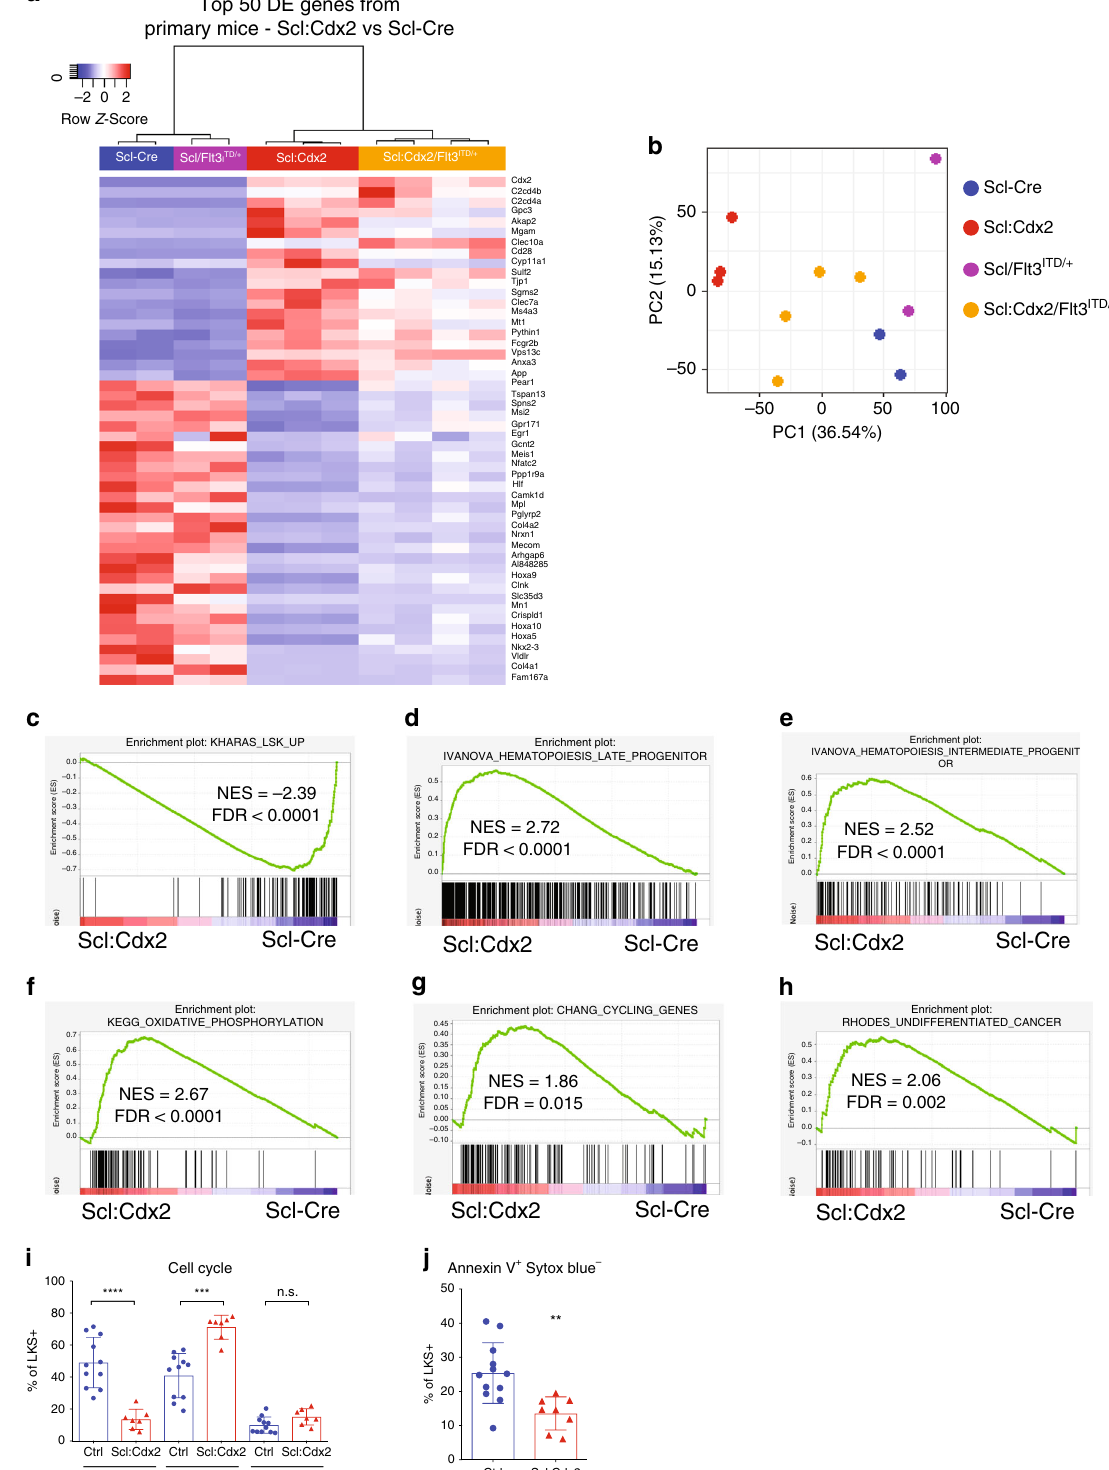
Fig. 5 Cdx2 confers a progenitor gene signature associated with differentiation. a Heatmap and unsupervised hierarchical clustering of top 50 differentially expressed genes from comparing Scl:Cdx2 and Scl -Cre on normalized read counts from RNA-Seq of BM LKS + cells of Scl -Cre, Scl:Cdx2, Scl/ Flt3 ITD/ + , and Scl:Cdx2/Flt3 ITD/ + mice. Color scale shows Z-score after row normalization. b Principal component analysis of the total RNA-Seq derived transcriptome. c – h Gene Set Enrichment Analysis (GSEA) on normalized read counts of transcripts from RNA-Seq of Scl -Cre ( n = 2) compared with Scl: Cdx2 ( n = 3). i Cell cycle analysis of BM LKS + cells ( Scl -cre n = 11; Scl:Cdx2 n = 7). j Apoptosis analysis of Annexin V-positive, Sytox-negative cells in BM LKS + by fl ow cytometry ( Scl -cre n = 12; Scl:Cdx2 n = 8). N = biologically independent animals. Statistical analyses of graphs performed using two-tailed Mann – Whitney test. Data are plotted as mean values + / − SD. n.s.; not signi fi cant. ** P < 0.01, *** P < 0.001, **** P <